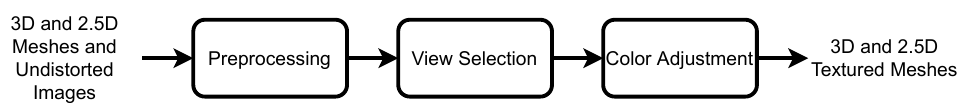
Figure 21. Flowchart illustrating the steps taken to compute texture models.